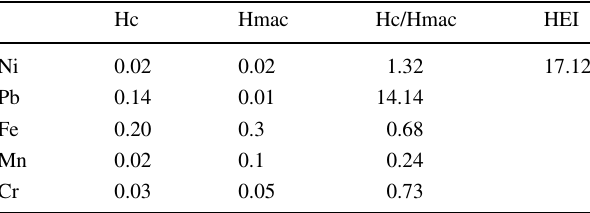
Table 3 Heavy metal evaluation index for groundwater at site 1